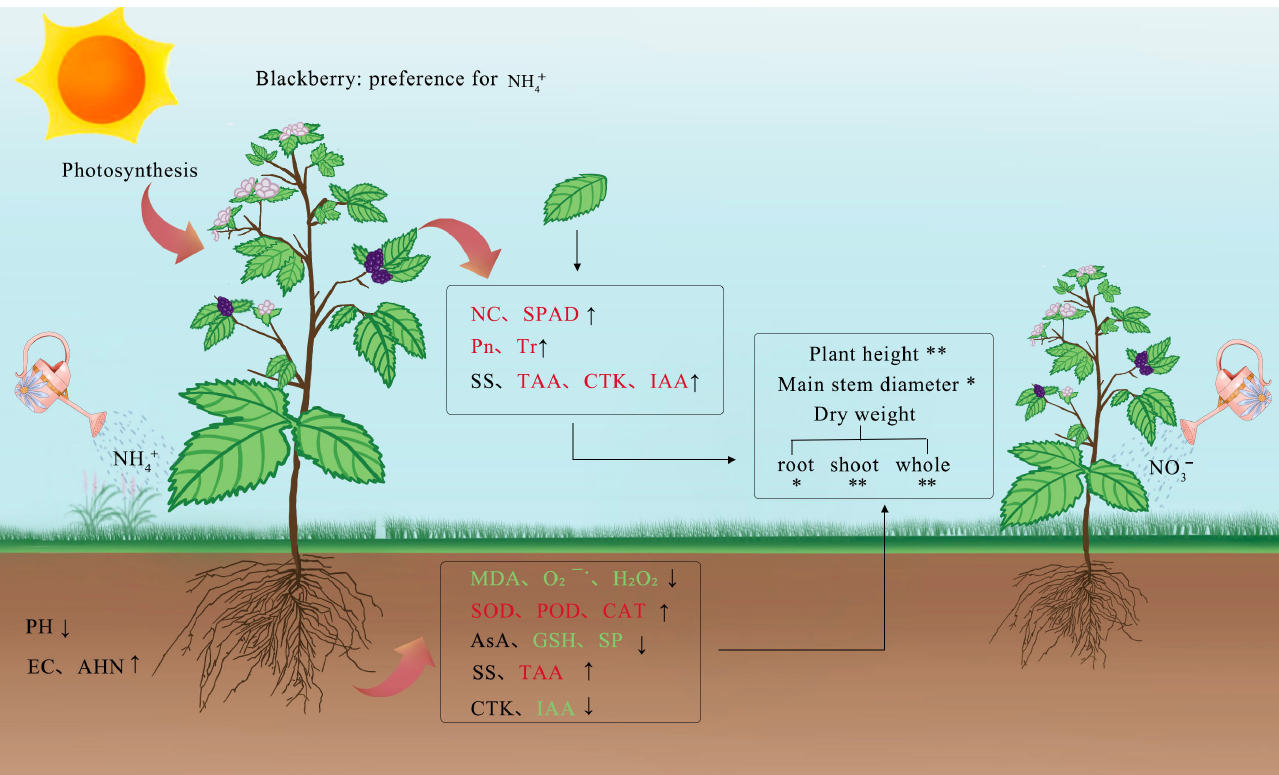
Figure 7. Physiological characteristics of whole blackberry plants with different N forms affected blackberry growth and the associated correlations: a possible physiological regulatory mechanism. The red font indicates that an indicator has a significant positive correlation with blackberry growth and the green font indicates a negative correlation. The upward arrow indicates that the value of this indicator increases with the NH 4+ –N treatment relative to the NO 3 − –N treatment, that is, NH 4+ /NO 3 − > 1; the downward arrow indicates the opposite. * represents p < 0.05, and ** represents p < 0.01.